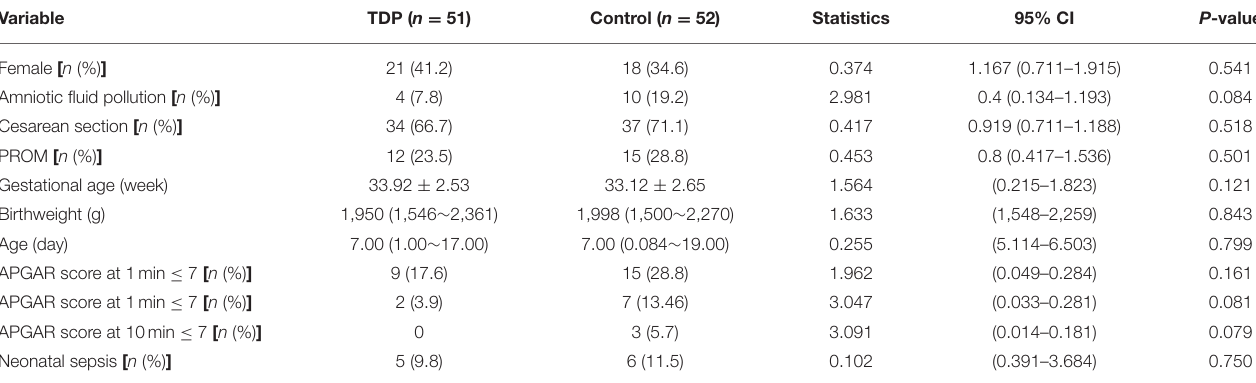
TABLE 1 | Comparison of the baseline data between the two groups. Variable